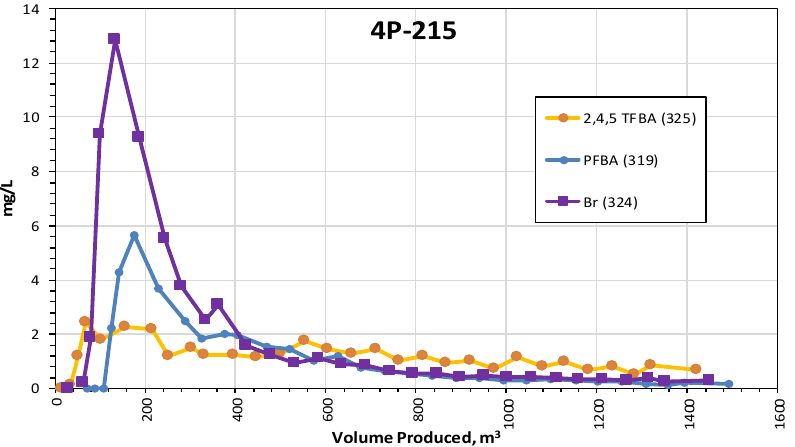
Figure A9. Tracer breakthrough curves as a function of volume produced in well 4P-215. Legend indicates number of the well into which each tracer was injected.